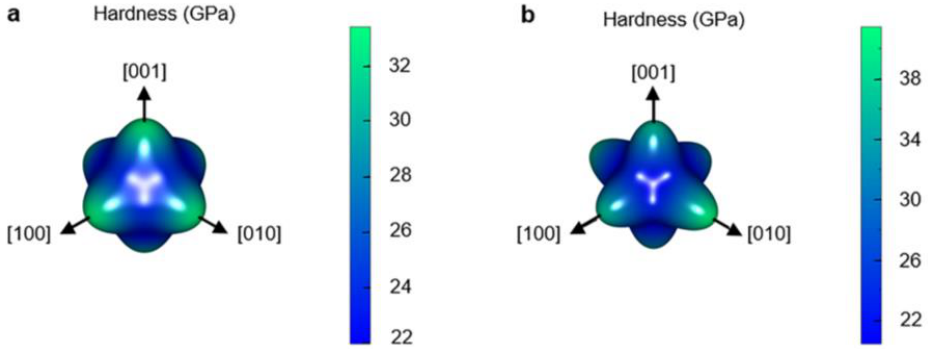
Figure 7. The direction-dependent hardness of ( a ) HfC and ( b ) Hf 0.5 Ta 0.5 C.